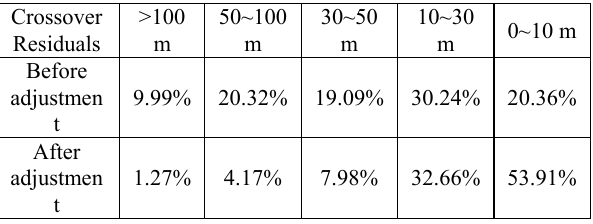
Table 1. The range distribution of crossover residuals